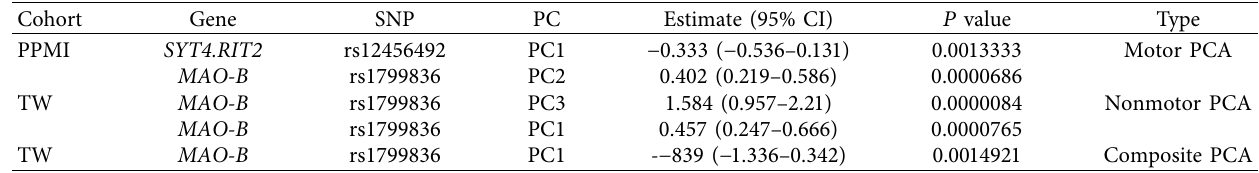
Table 3: Association between SNPs and PCA progression in the TW and PPMI cohorts. Cohort